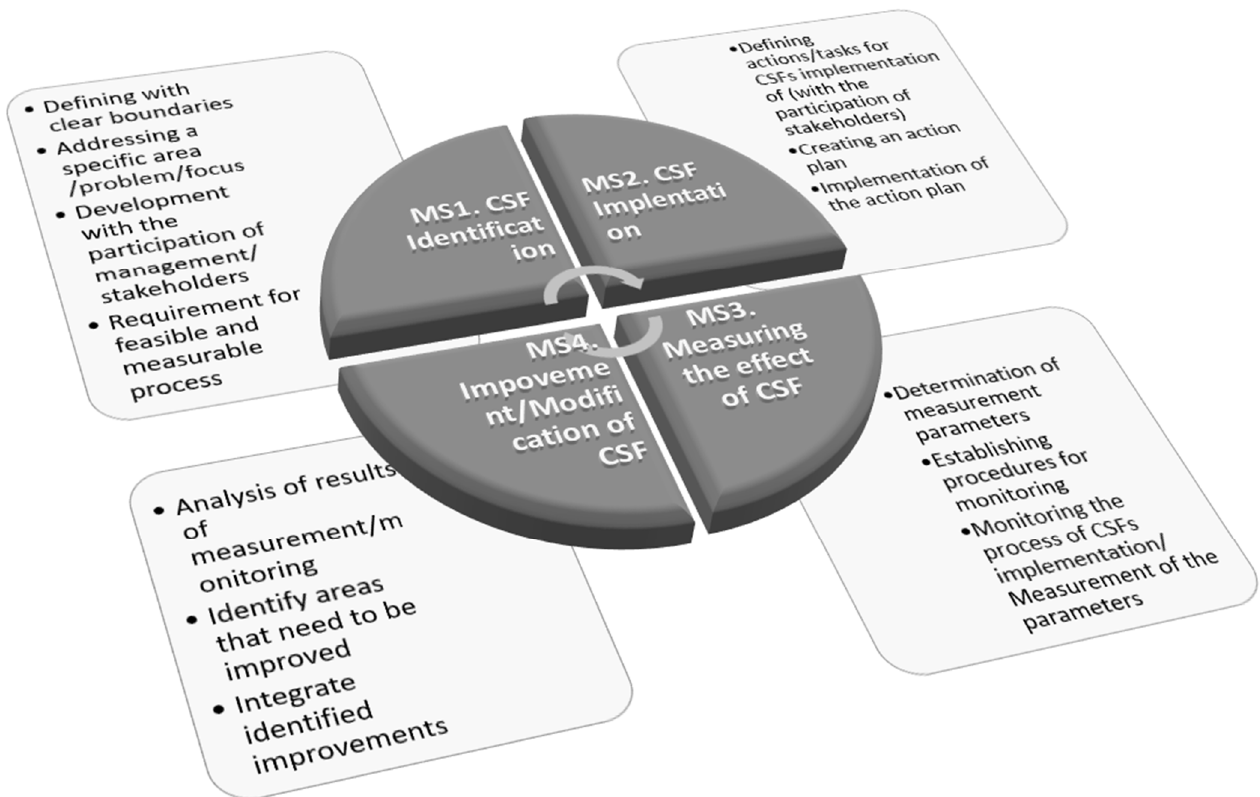
Figure 7. Model for monitoring of CSFs.